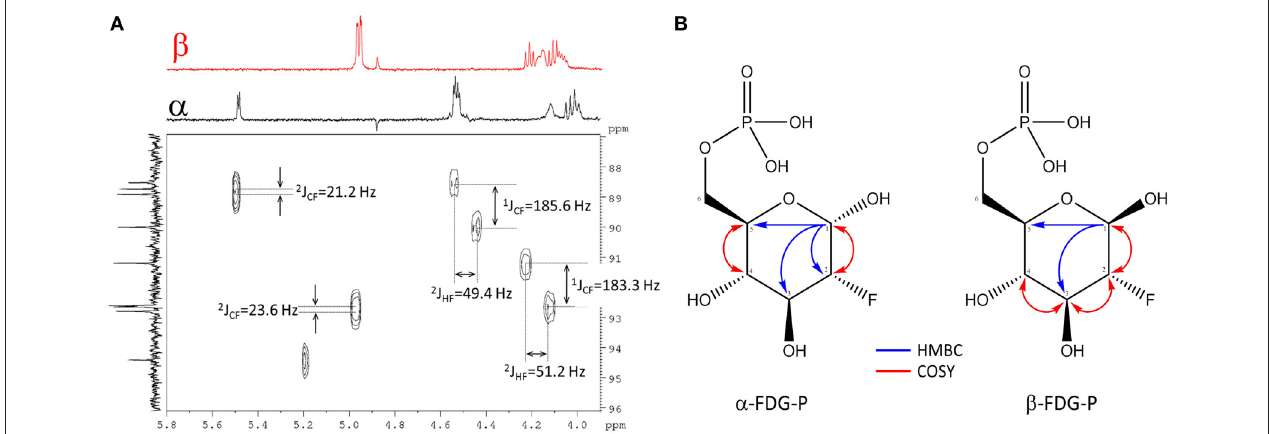
FIGURE 3 | Assignment of FDG-6-P. (A) Section of the 1 H- 13 C HSQC spectrum of FDG-6-P. The red F 2 -projection represents the selective TOCSY spectrum of β -FDG-6-P, the black F 2 -trace belongs to α -FDG-6-P. The F1-projection shows the 13 C-NMR spectrum. Coupling constants were extracted from 1 H- and 13 C-NMR spectra, respectively. (B) 2D-NMR key correlations used for the assignment of FDG-6-P ( α -FDG-6-P and β -FDG-6-P forms, respectively). Blue arrows represent